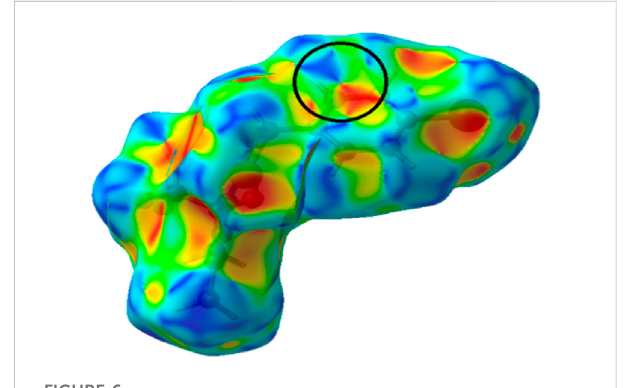
Hirshfeld surface mapped in shape index for H 2 L 1 .